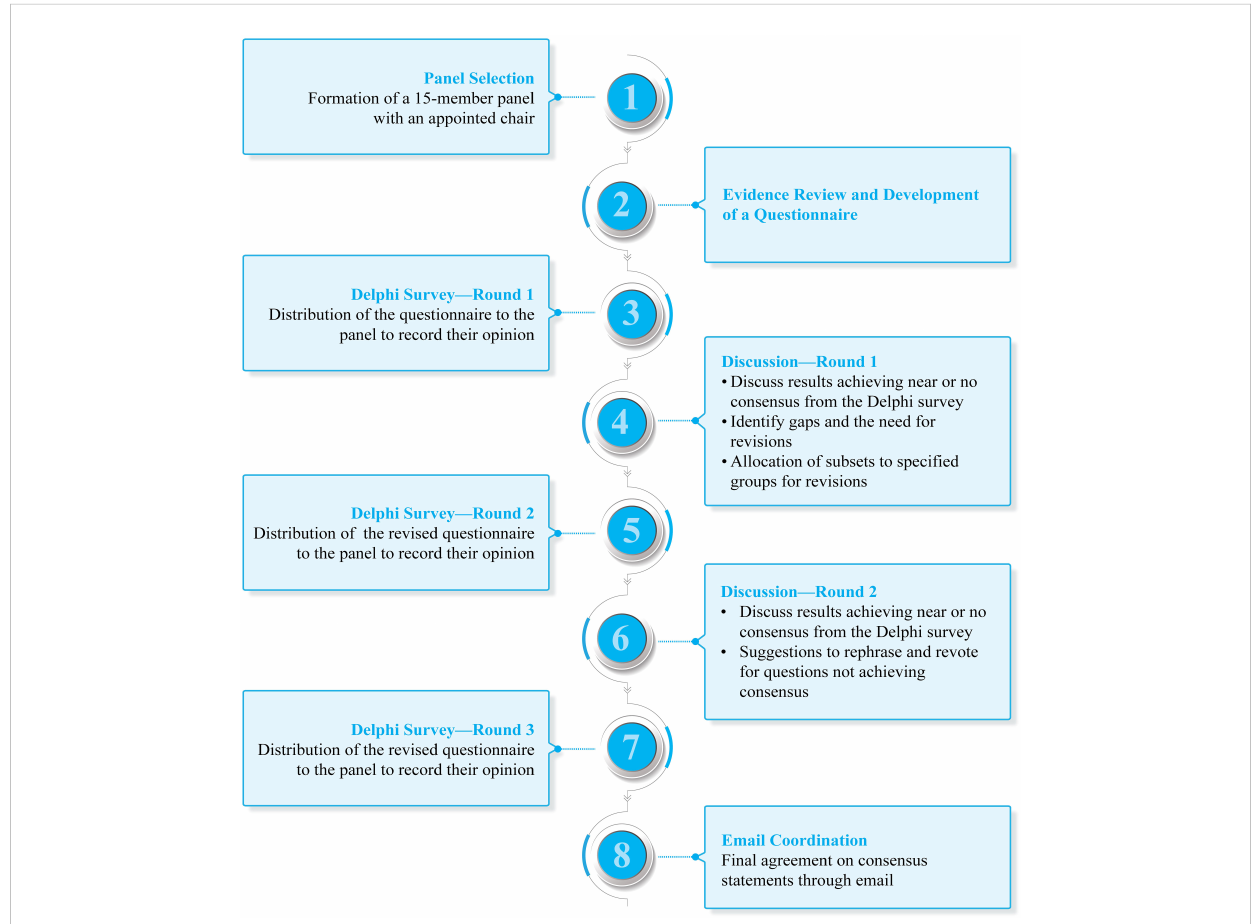
FIGURE 1 Overview of the consensus process used to create the clinical consensus